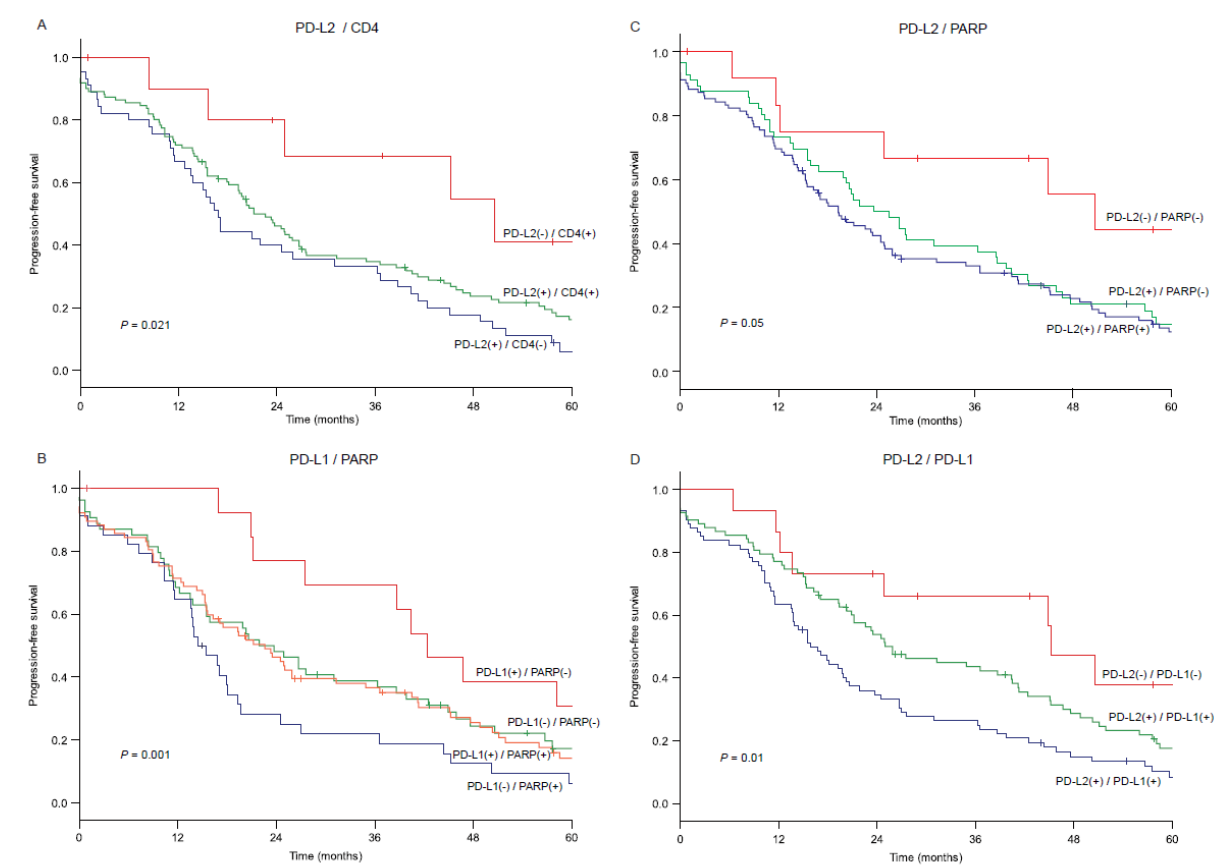
Figure 3. Survival curves for progression-free survival based on combination patterns. Survival curves are constructed with the Kaplan–Meier method per the combination pattern of biomarkers. ( A ) PD-L2 and CD4; ( B ) PD-L1 and PARP; ( C ) PD-L2 and PARP; ( D ) PD-L2 and PD-L1. In Figure panels ( A , C , D ), subgroups with small number (<9) were censored due to futility. Log-rank test for p -values.